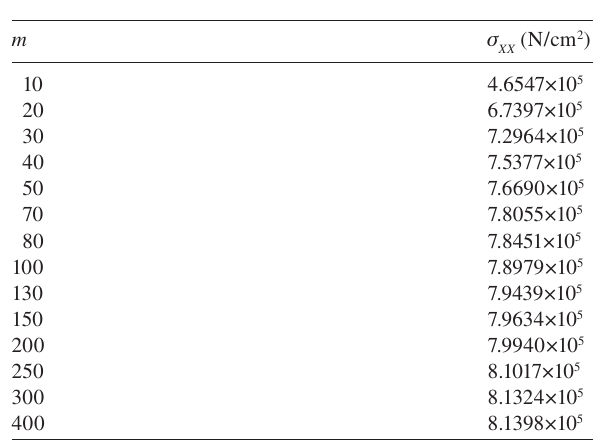
Table 2 Convergence analysis for stresses at the fi xed end on the top fi ber of the full metal cantilever beam under distributed load q = 750 N/cm 2